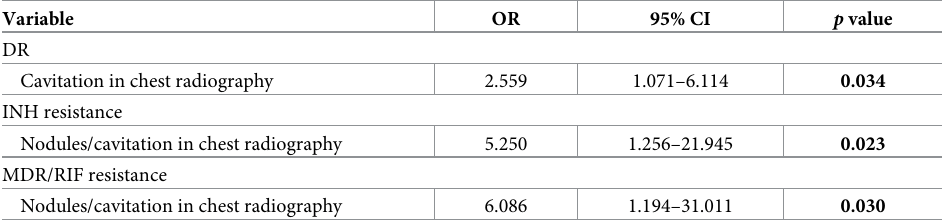
Table 1. Multivariate analysis of patients’ characteristics by DR, INH resistant, and MDR/RIF resistant